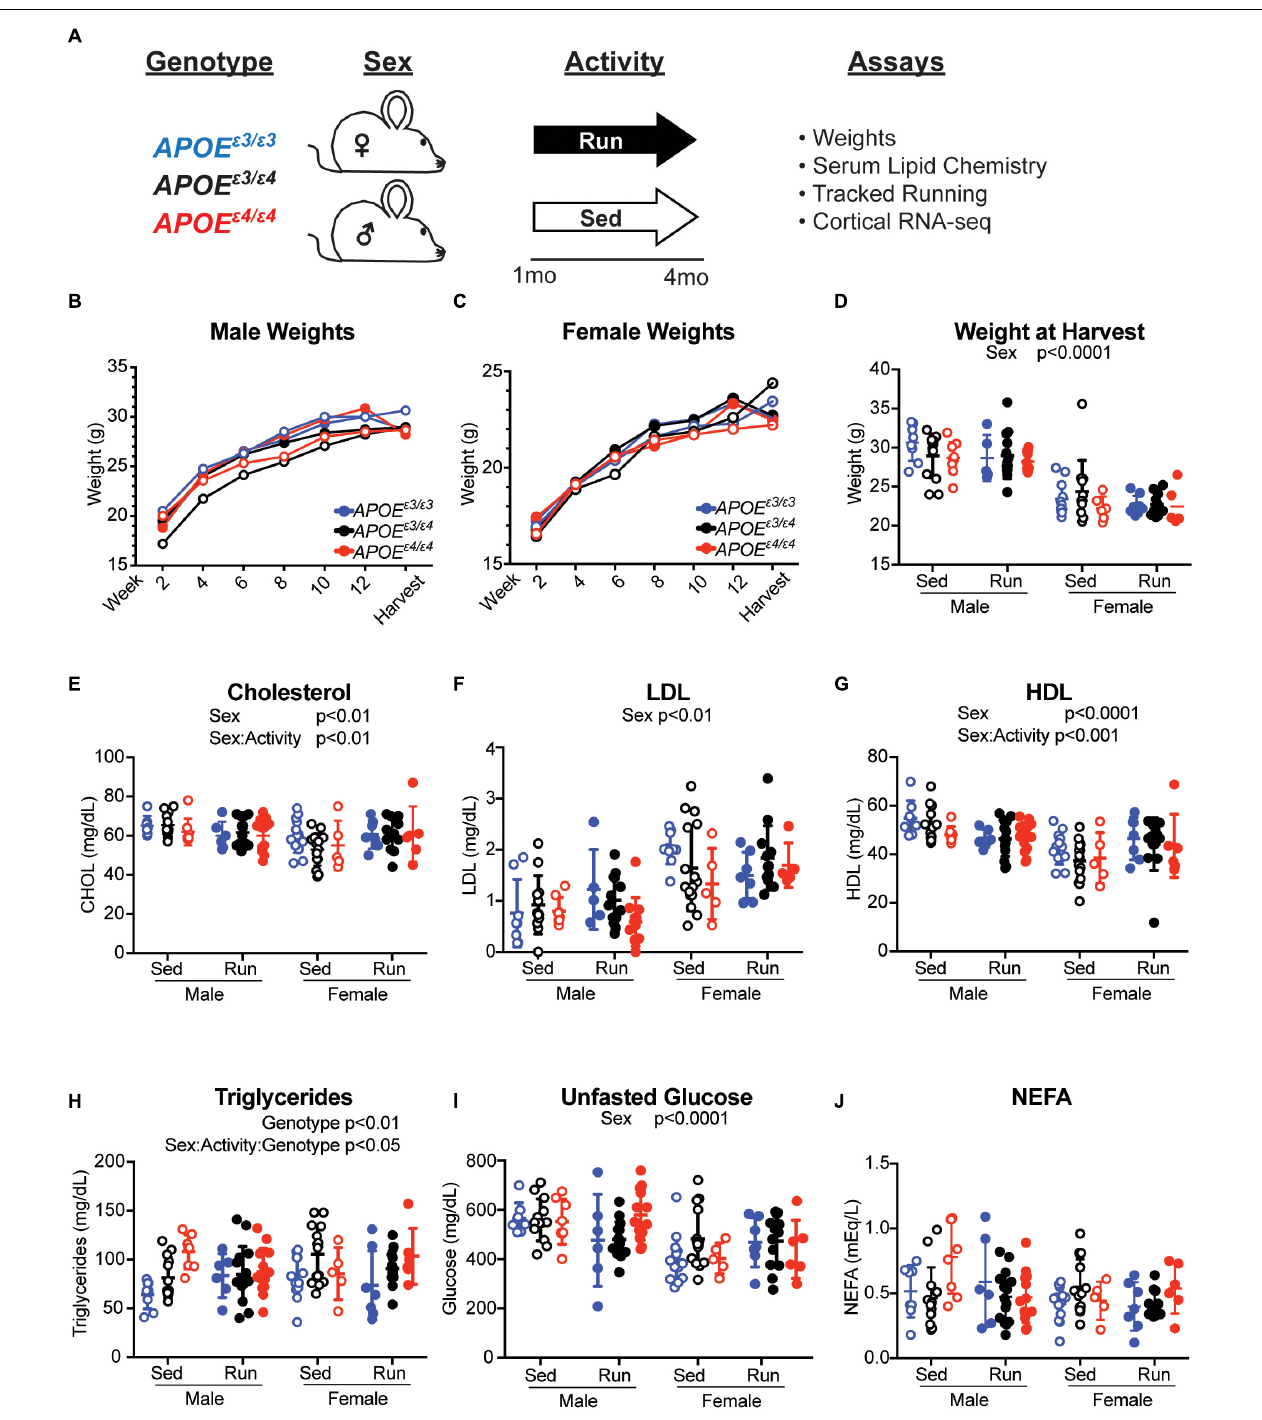
FIGURE 4 | APOE genotype did not affect weight or cholesterol composition at 4 months. (A) Schematic of experiment and timeline. (B,C) Weights of male (B) and female (C) mice over the course of the running experiment. (D) Weight at harvest of both male and female mice across APOE genotypes showed a significant effect of sex. (E) Plasma total cholesterol concentrations revealed a main effect of sex and an interactive effect between sex and activity. (F) LDL concentration revealed a significant effect of sex. (G) HDL concentration revealed a significant effect of sex and interactive effect between sex and activity. (H) Triglyceride concentrations revealed a significant effect of APOE genotype and an interactive effect between sex, activity and APOE genotype. (I) Unfasted glucose concentrations revealed an effect of sex. (J) Non-esterified fatty acid (NEFA) concentrations revealed no significant effects. Significant ANOVA results are stated under the title of the graph, significant Tukey post hoc results can be found in Supplementary Table 2